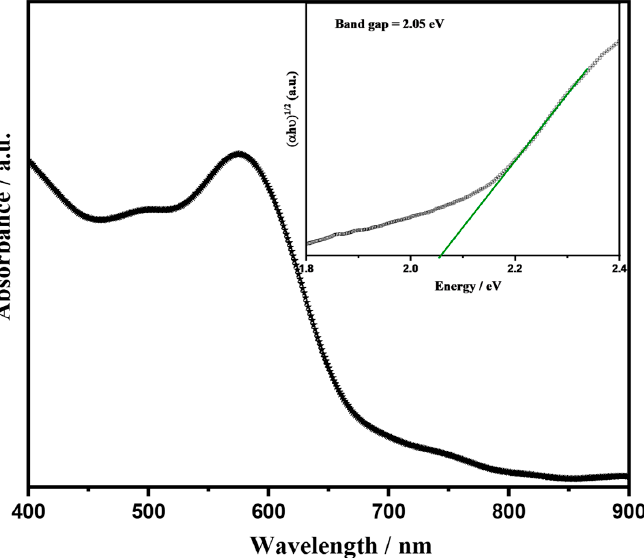
Figure 5. UV–Vis spectrum of the prepared thin film of MA 3 Sb 2 I 9 on the FTO substrate. Inset; Tauc plot.